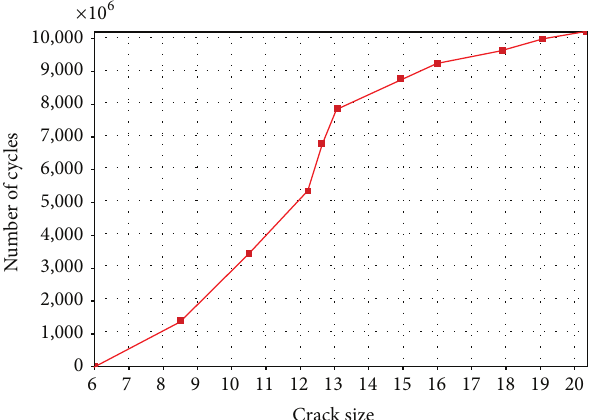
Figure 9: Relationship between loading cycle and crack